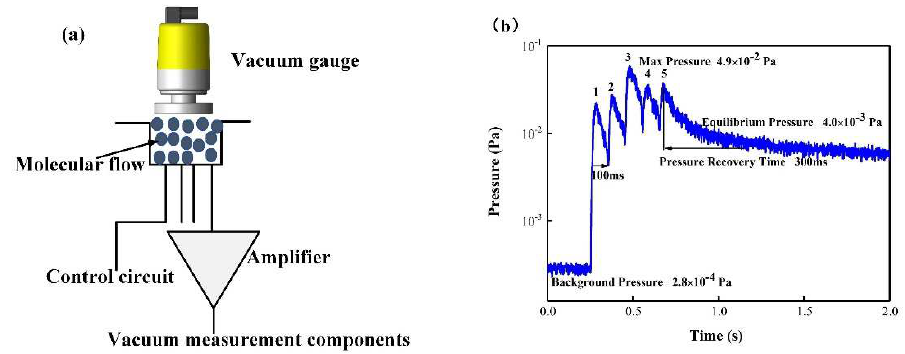
Figure 8. ( a ) Schematic of the online vacuum measurement. ( b ) Diode pressure obtained by the online vacuum-measurement method.